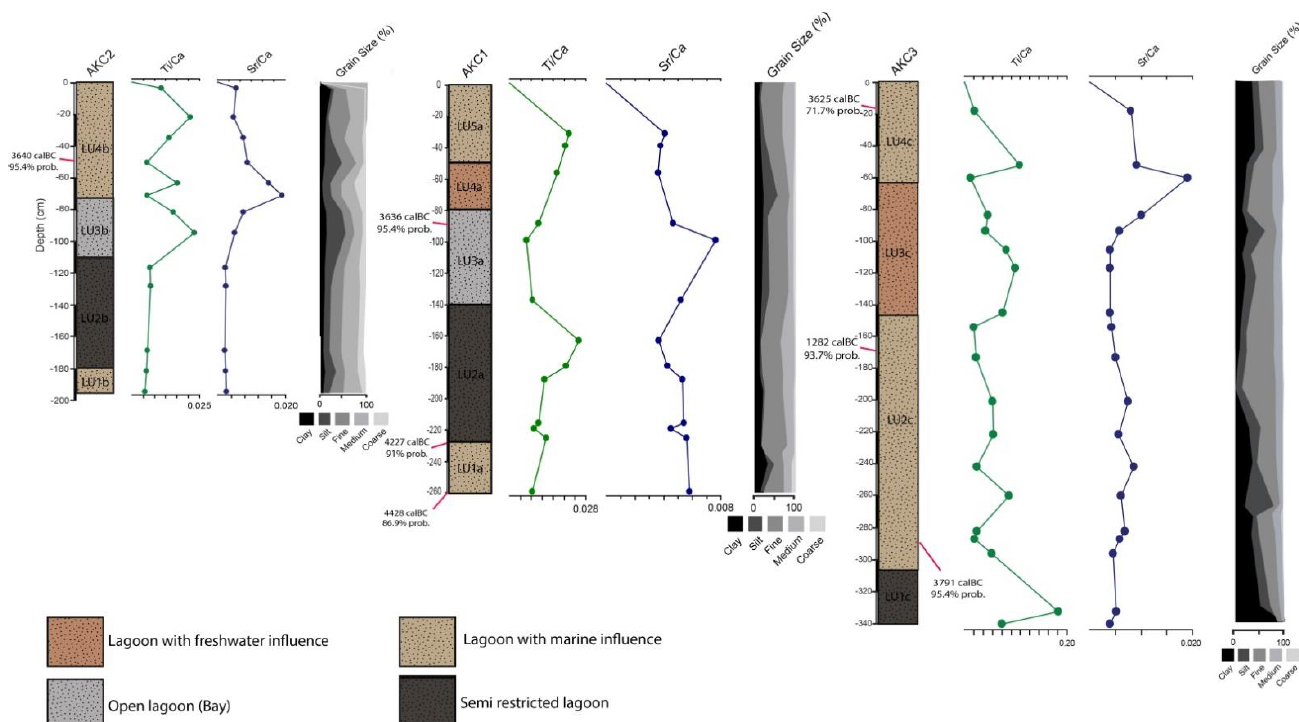
Figure 3. XRF data, grain size analysis and palaeoenvironmental interpretation of the cores.